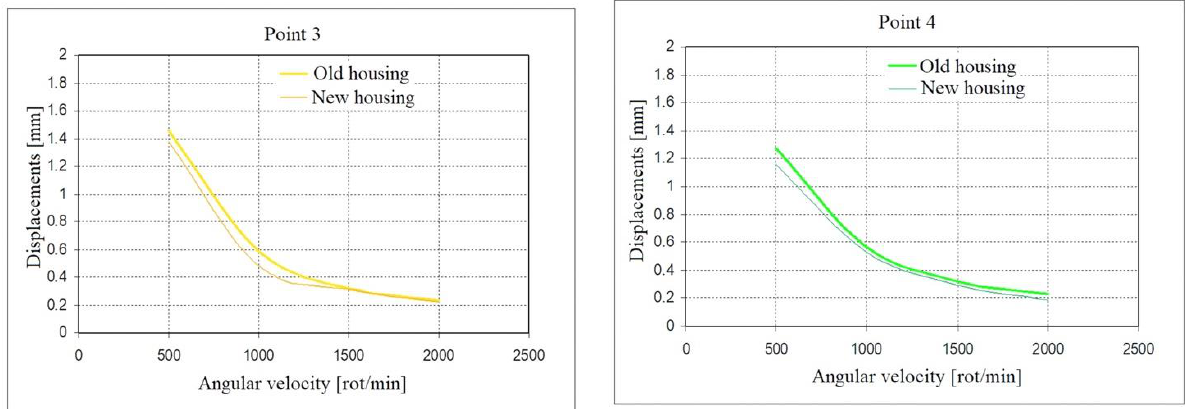
Figure 27. Displacements in measuring points 1 and 2 on the two summing boxes (old and new version).